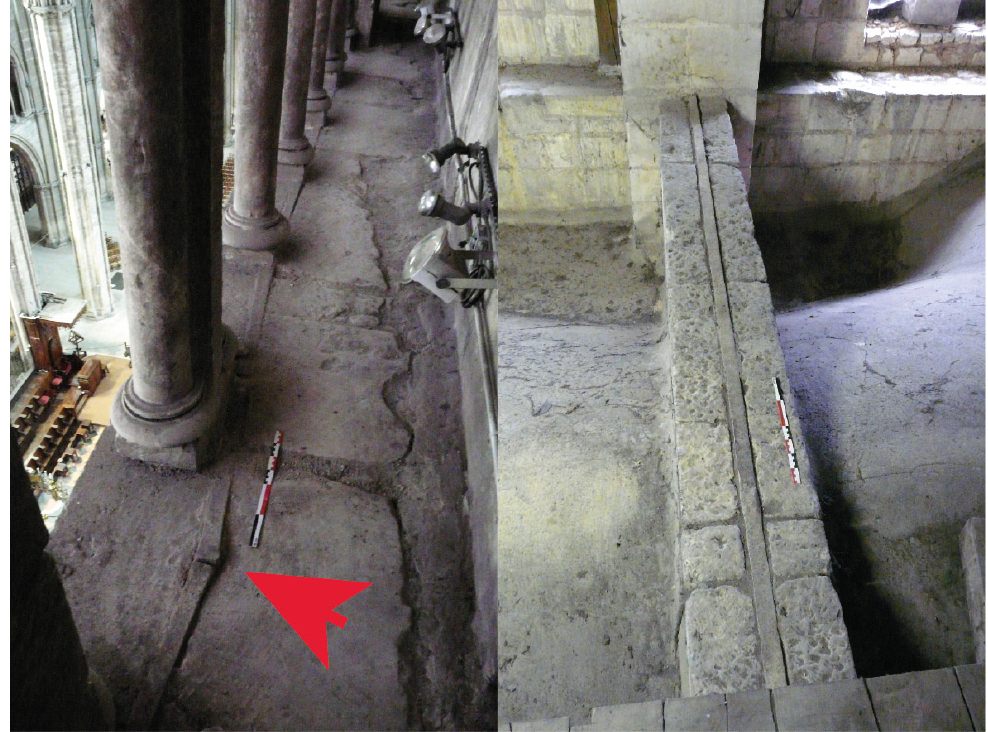
Figure 2. ( left ) Triforium chain (red arrow). View of the north side in the 2nd bay, ( right ) Attic tie rod TN4.